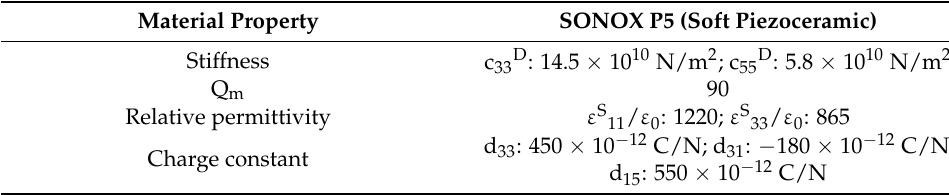
Table 1. Material properties for the material of SONOX P5, extracted from